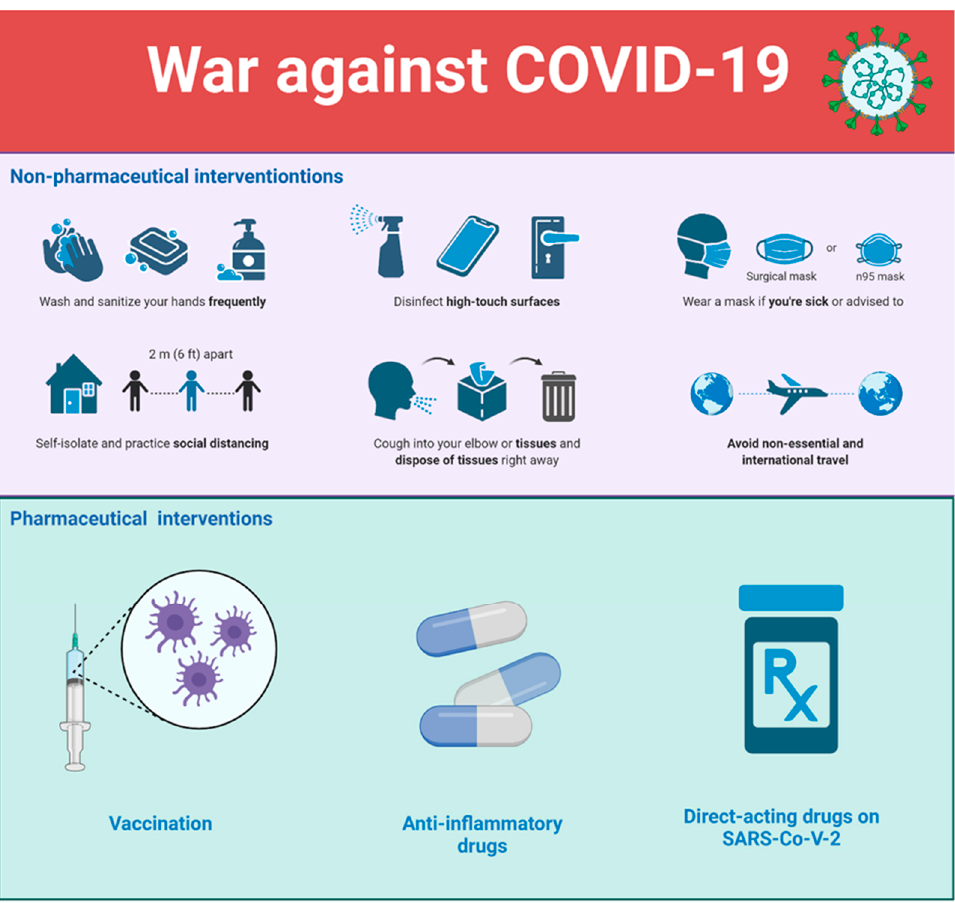
Figure 1. The war against COVID-19 includes multiple strategies. Both pharmaceutical and non- pharmaceutical interventions are needed now and may be needed for a long time.